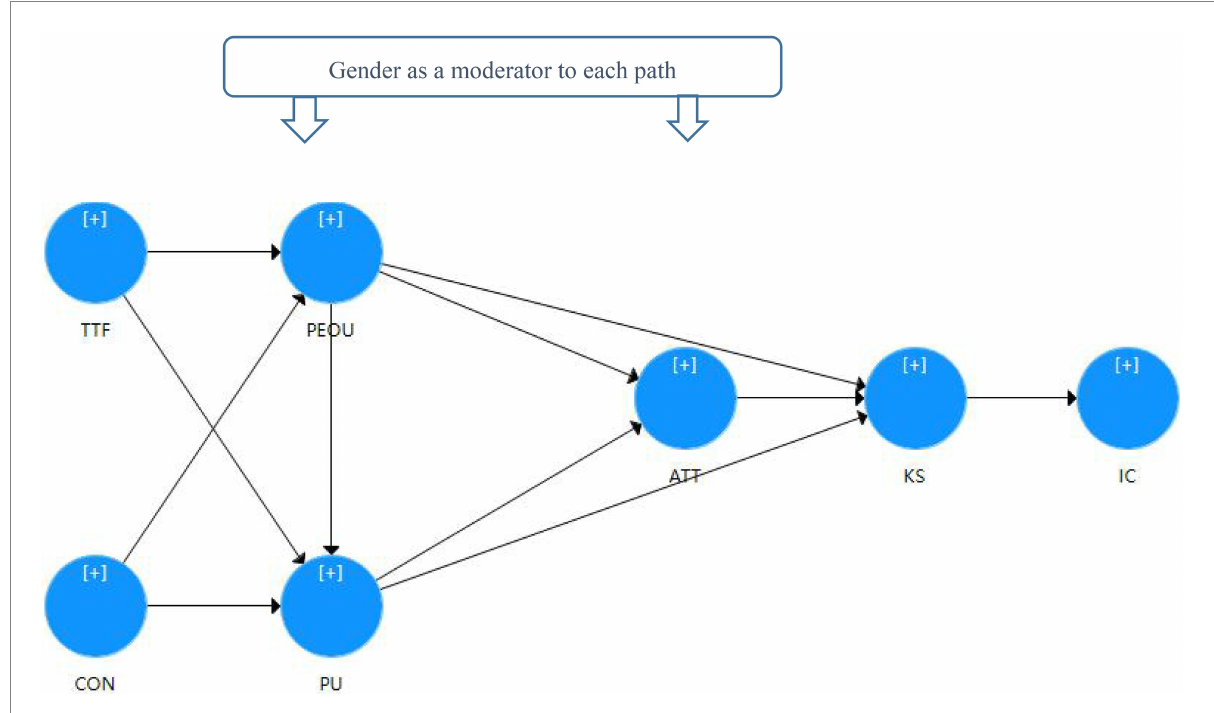
FIGURE 1 Research framework for online learning and